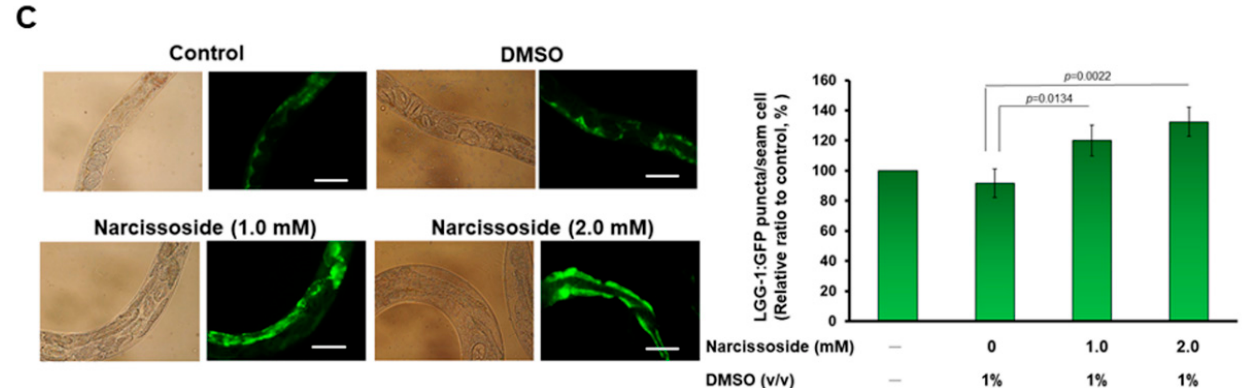
Figure 11. α -Synuclein accumulation in nematode muscle cells is diminished by narcissoside (NCS)- induced autophagy. ( A ) NL5901 nematodes at the L3 stage were treated with NCS for three days. The fluorescence intensity exhibited by accumulating α -synuclein in muscle cells was then analyzed using a fluorescence microscope (Leaf panel). The fluorescence intensity was quantified using ImageJ software (Right panel). ( B ) The expression of α -synuclein in each group of nematodes in ( A ) was analyzed by Western blotting. β -actin is an internal loading control (top panel). The fluorescence intensity was quantified using ImageJ software (bottom panel). ( C ) DA2123 nematodes at the L3 stage were treated with NCS for three days. The dots formed by the autophagy marker LGG-GFP in seam cells were observed (Leaf panel) and counted by a fluorescence microscope. The right panel is the average result of the fluorescent dot count analysis of all seam cells in each group of worms.